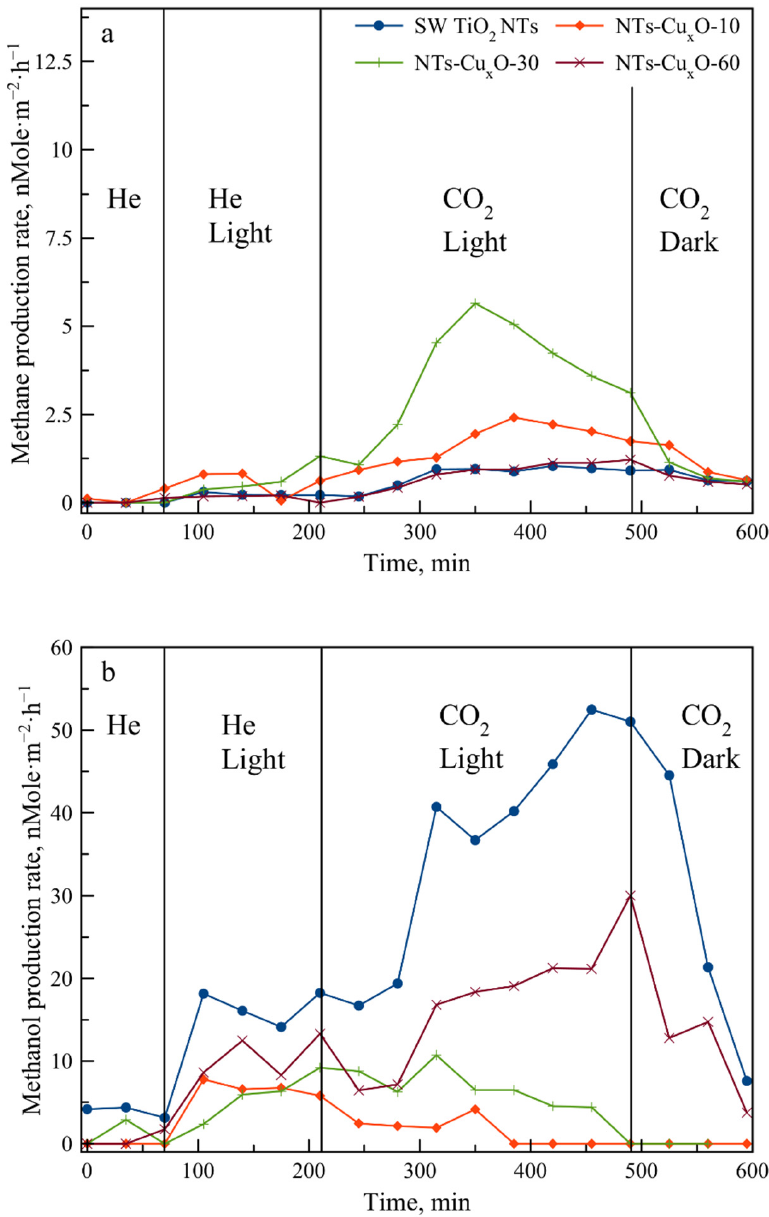
Figure 3. Kinetics of CO 2 photoinduced conversion in gas phase under illumination UV-A (370 nm): to methane ( a ), to methanol ( b ).